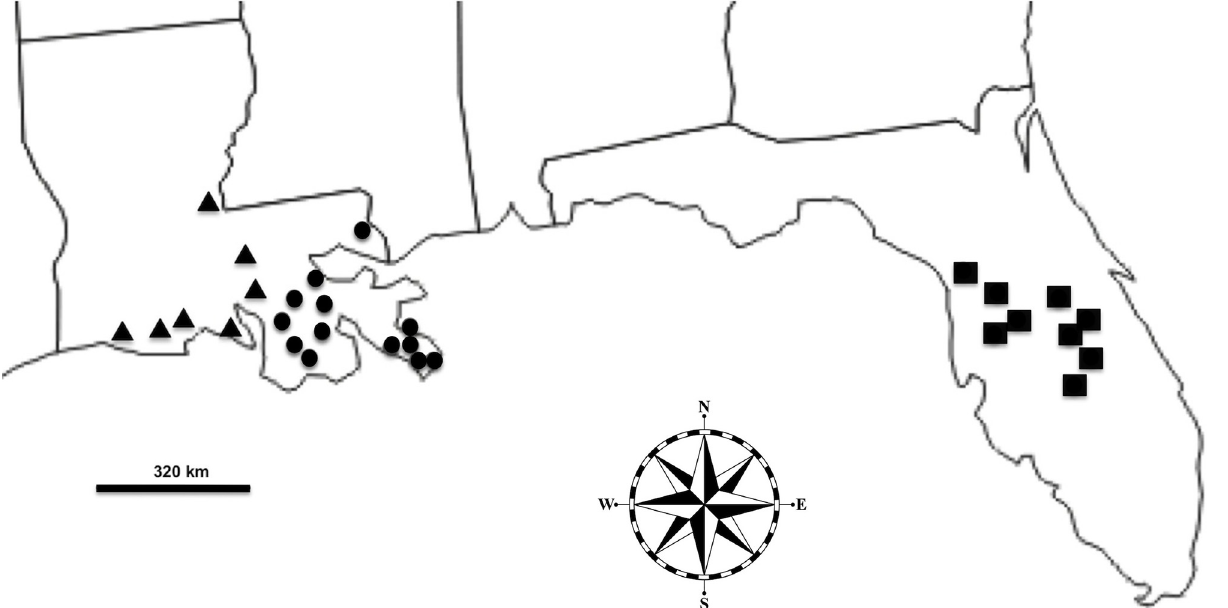
Fig 1. Map of collection sites in Louisiana West Zone (triangles), Louisiana East Zone (circles), and Florida (rectangles).